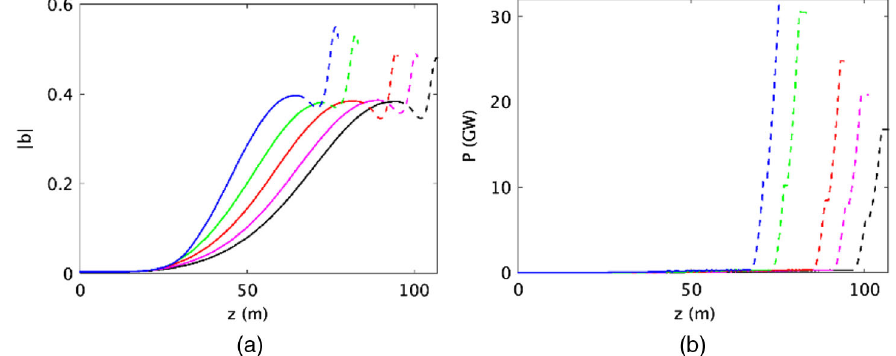
FIG. 5. Simulation results of the existing method (black lines) and the modified reverse tapering method with 1 (magenta lines), 2 (red lines), 3 (green lines), and 4 (blue lines) untapered planar undulators along the planar undulator line (solid lines) and the helical undulator line (dashed lines). (a) Bunching factor and (b) radiation